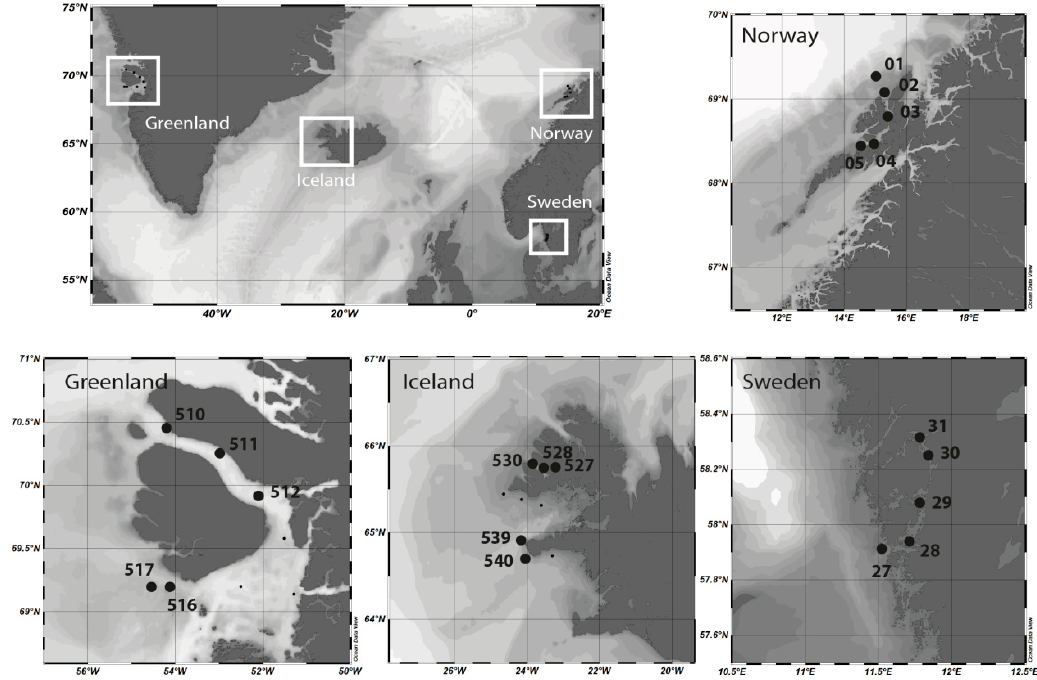
Figure 1. Study sites and sampling stations on the coast of west Greenland, northwest Iceland, Norway and Sweden.